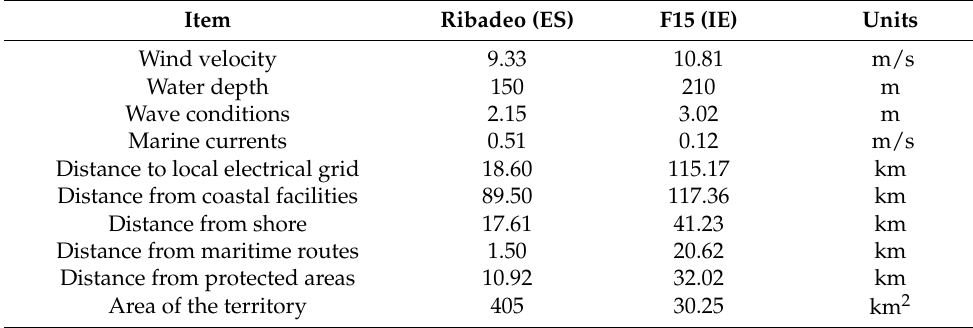
Table 2. Main characteristics of the Ribadeo (ES) and F15 (IE)